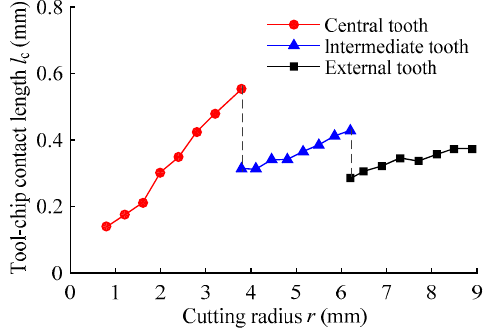
Figure 12. Distribution of the tool–chip contact length along cutting radius.